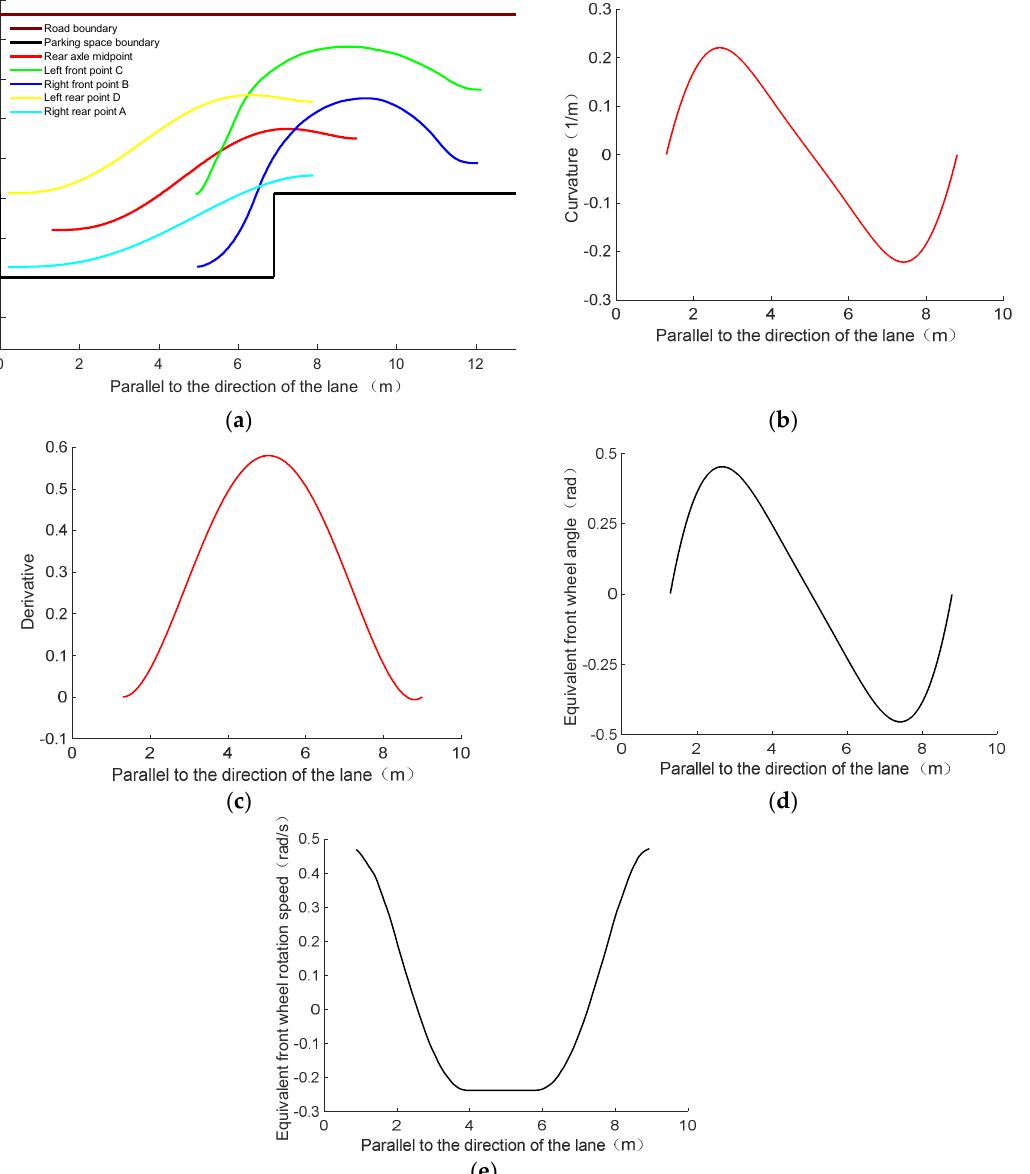
Figure 5. Parallel parking path planning simulation results. ( a ) Vehicle rear axle midpoint trajectory. ( b ) The curvature of the path curve. ( c ) The derivative of the path curve. ( d ) Equivalent front wheel angle. ( e ) Equivalent front wheel rotation speed.